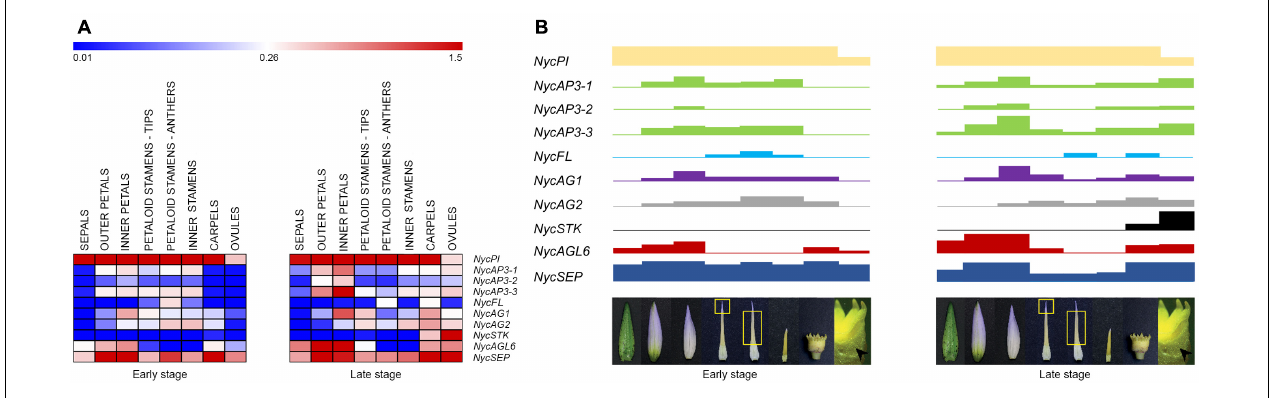
FIGURE 6 | MADS-box gene expression in the various floral components and flower developmental model in Nymphaea caerulea . (A) Heat-map of the MADS-box gene expression levels at two developmental stages (early and late, respectively) of flower development. Expression values were scaled by 2 − (cid:49) Ct obtained by qPCR experiments. (B) Block expression model showing the contribution of each gene in the tissues analyzed (from left to right: sepals, outer petals, inner petals, cerulean tips of petaloid stamens, anthers of petaloid stamens, inner stamens, carpels, and ovules). Rectangle heights from (A)